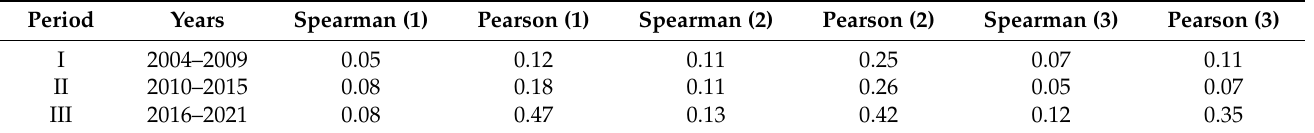
Table 2. Spearman rank correlation and Pearson linear correlation between ( 1 ) GT earthquake insurance and GT earthquake daily data; ( 2 ) GT earthquake and the magnitude of earthquakes (M ≥ 5.0) occurred in California and bordering areas; ( 3 ) GT earthquake insurance and the magnitude of earthquakes occurred in California. In cases of more than one earthquake the same day, the highest magnitude was